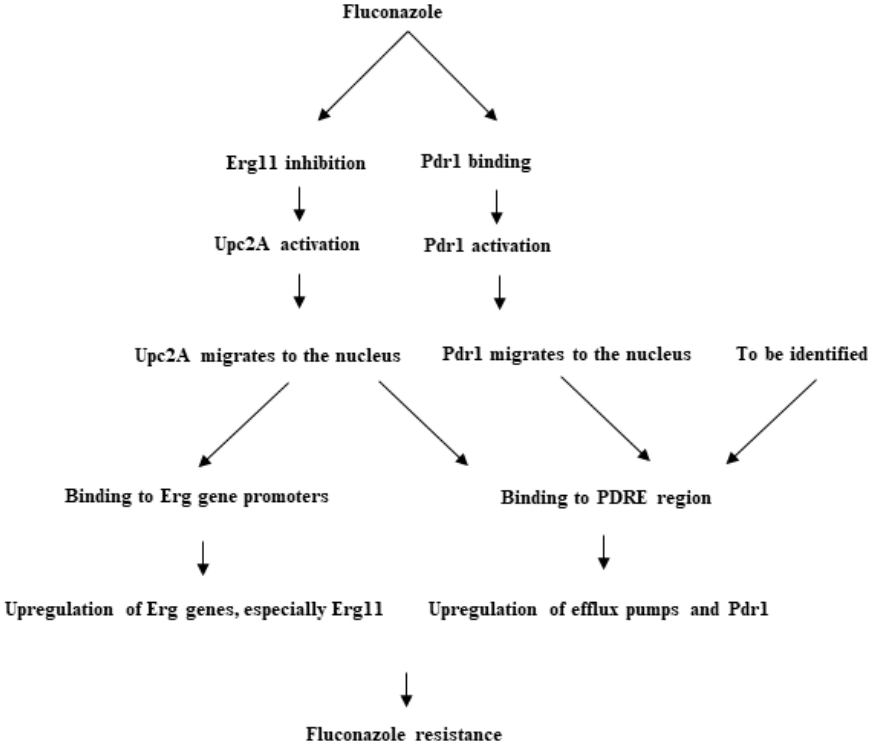
Figure 4. Fluconazole resistance is mediated by both Upc2p and Pdr1p in C . glabrata